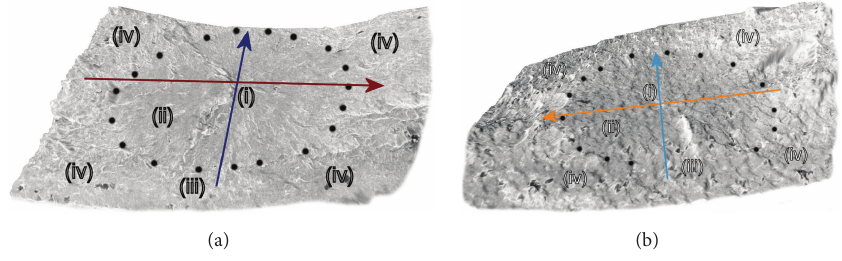
Figure 2: 3D images of the fish-eye cracks from Figure 1.